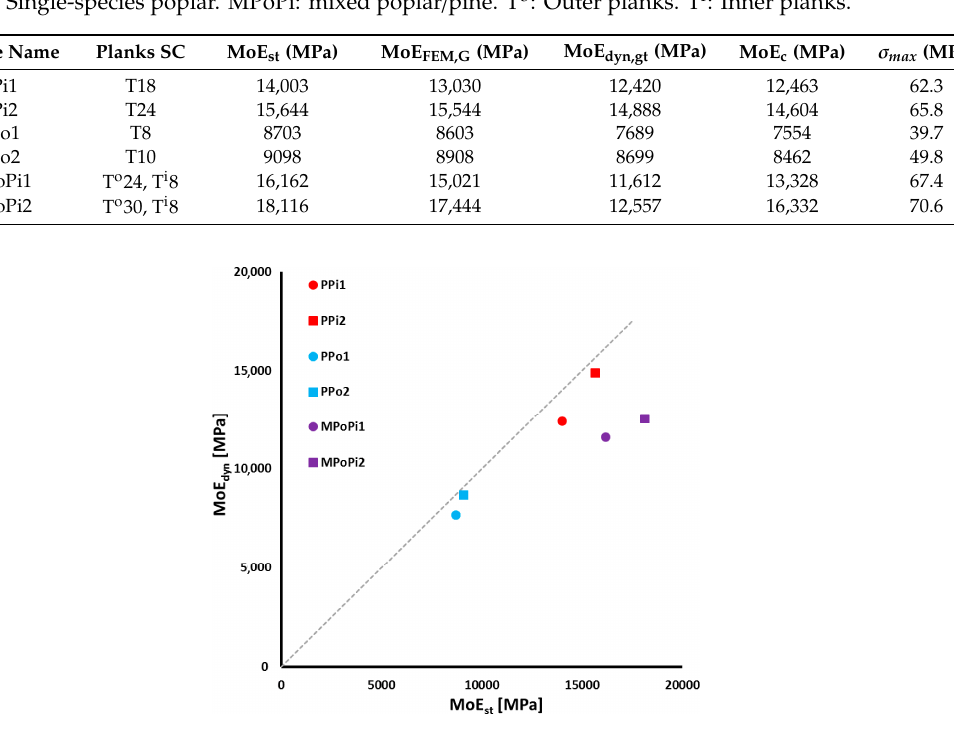
Figure 11. Comparison between modulus of elasticity for the tested samples. MoE dyn,gt : dynamic modulus of elasticity. MoE st : static modulus of elasticity. Gray dotted line: y = x.